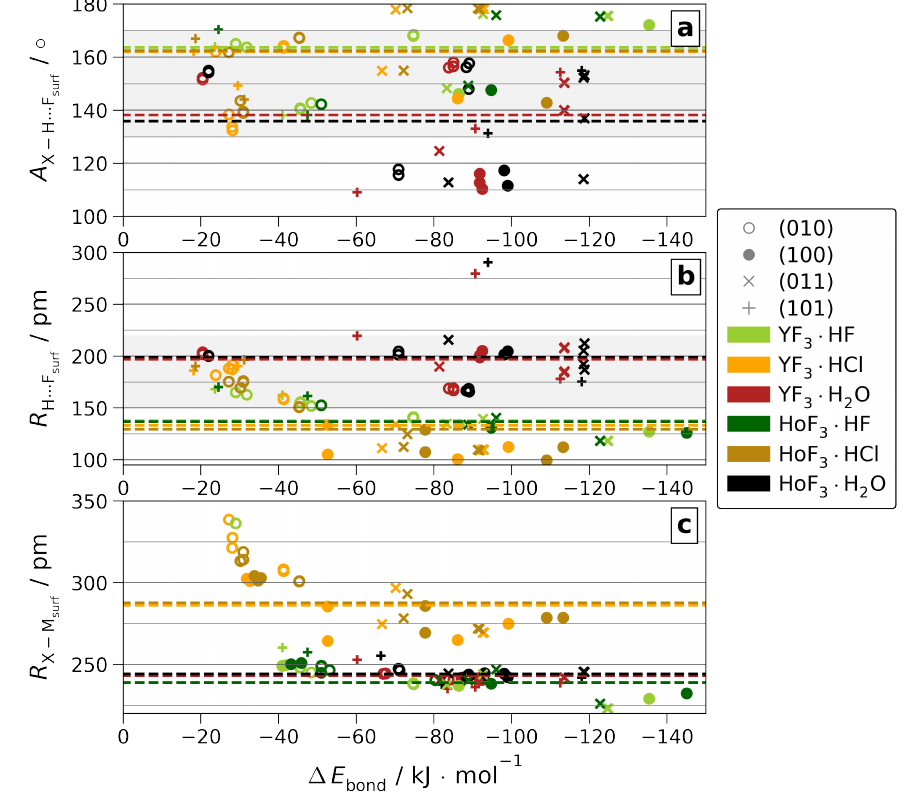
Figure 6. H-bond angles ( A X–H ··· F ( a )) and distances ( R H ··· F ( b )) or direct surface coordination surf surf distances of X = O/F/Cl ( R X–M ( c )) vs. ∆ E bond for all non-hydride-forming adsorptions. The surf respective ∆ E bond -weighted means over all surfaces are given as dashed lines. The area of H-bonds classified as moderate [34] is